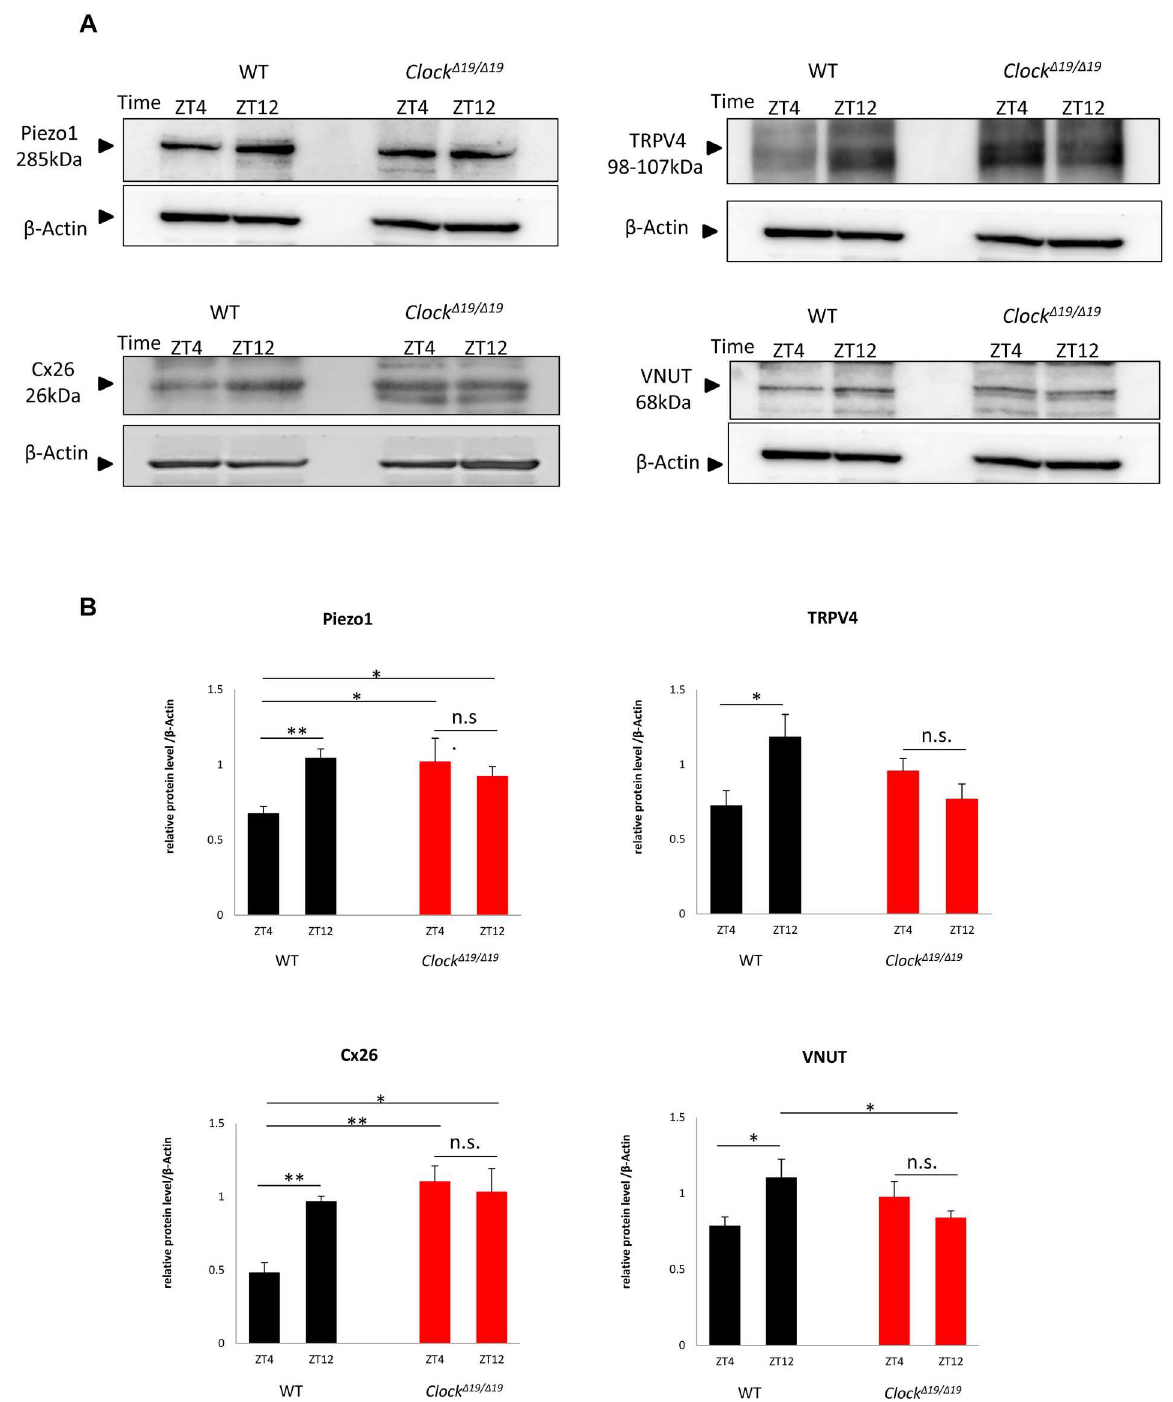
Fig 3. Protein expression rhythms of mechanosensor, Cx26 and VNUT in the mouse bladder mucosa. (A) Representative band image of Piezo1, TRPV4, Cx26, and VNUT proteins by Western blotting of the mouse bladdermucosa of WT and Clock Δ 19/ Δ 19 mice betweenZT4 and ZT12. (B) Quantitative analysisof Piezo1, TRPV4, Cx26, and VNUT proteins by Western blotting of the mouse bladdermucosa of WT and Clock Δ 19/ Δ 19 mice betweenZT4 and ZT12. N = 5 for WT mice, N = 5 for Clock Δ 19/ Δ 19 mice at each point in a protein quantitative analysis. * P < 0.05, ** P < 0.01, n.s., not significantby Mann-Whitney’s U -test.